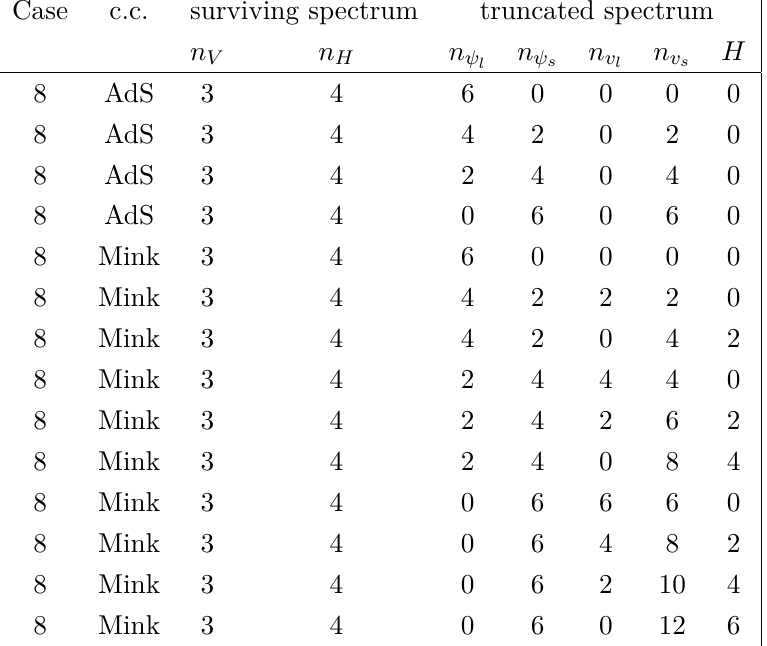
Table 6 . Supersymmetry breaking patterns and truncation of the spectrum — case 8.